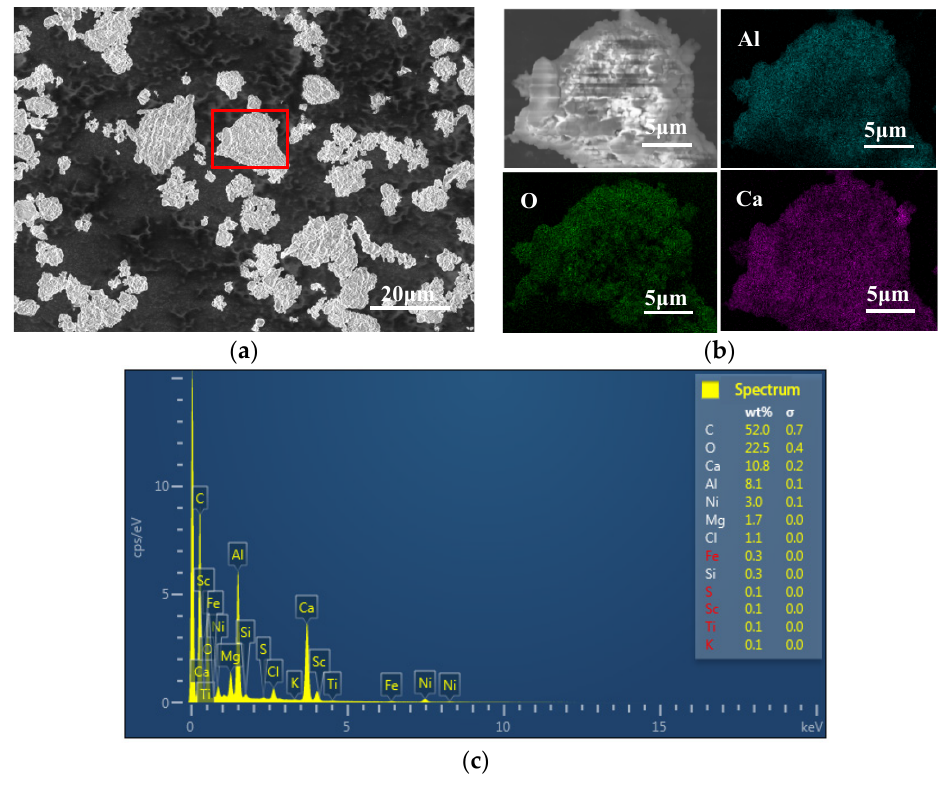
Figure 9. ( a – c ) SEM-EDS image of calcium oxide-added roasted sample under m calcium oxide : m aluminum dross = 0.4, roasting temperature = 900 °C, roasting time = 5